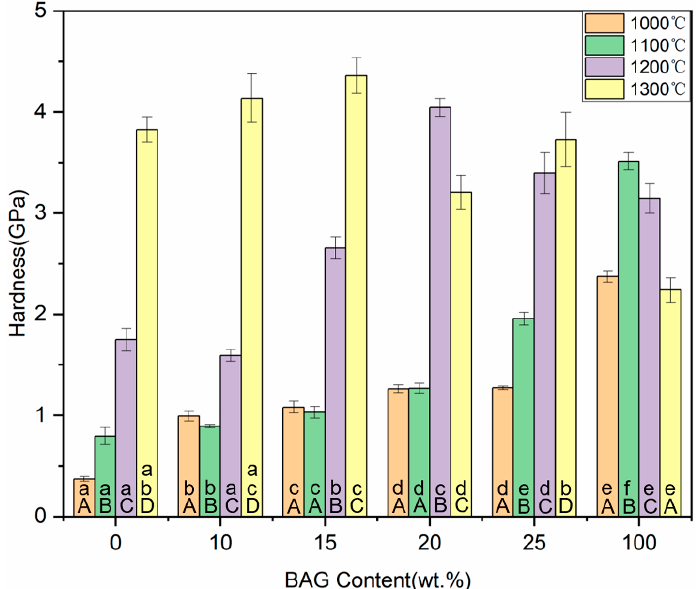
Figure 10. Hardness of specimens with different sintering temperatures and different BAG content. a the same lowercase letters indicate that there was no significant difference between different BAG contents at the same sintering temperature ( p = 0.05). A the same uppercase letters indicate that there was no significant difference between different sintering temperatures with the same BAG content ( p = 0.05). The data were significantly drawn from a normally distributed population at the 0.05 level.